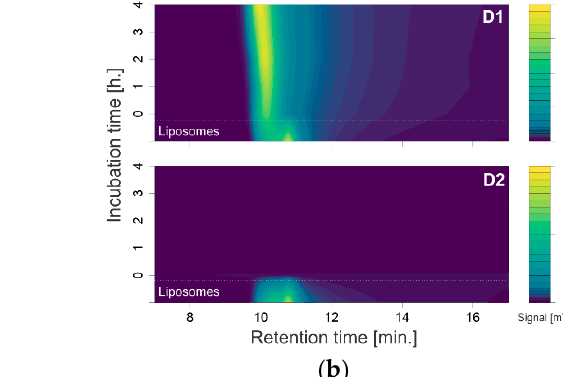
Figure 3. ( a ) Absorption chromatograms of liposomes depending on the time of incubation of added dendron with liposomes at temperature of 37 °C. The nested graph shows the area under the peak of liposomes with dendrons at the corresponding time point. ( b ) Contour plots of liposome absorb- ance at different incubation times of dendrons with liposomes, top—first-generation dendron; bot- tom—second-generation dendron.